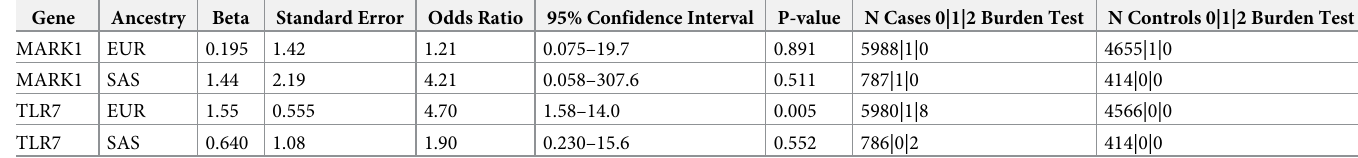
Table 3. Replication of M1 mask, severe COVID-19, MARK1 and TLR7 results in the GenOMICC cohort. Note that the same variants were included in both the MAF < 1% and MAF < 0.1% replication, and the same results were obtained (shown here). Gene Ancestry Beta